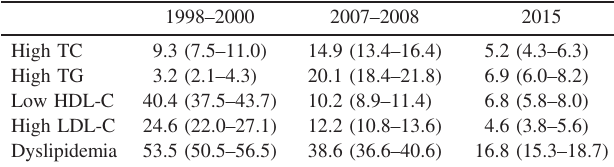
Table 1. Demographic characteristics of subjects, 1998 – 2015